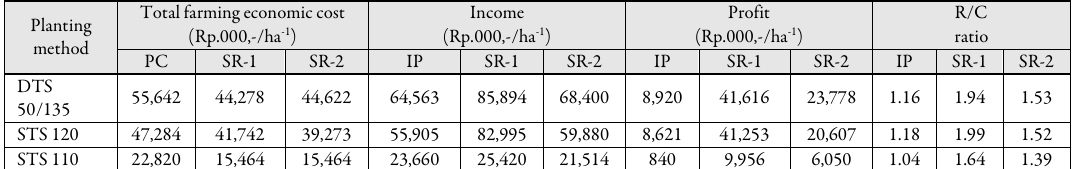
Tabel 5. Partial farming economic analysis of sugarcane under different planting methods of DTS 50/135, STS 120 and STS 110 for PS.862